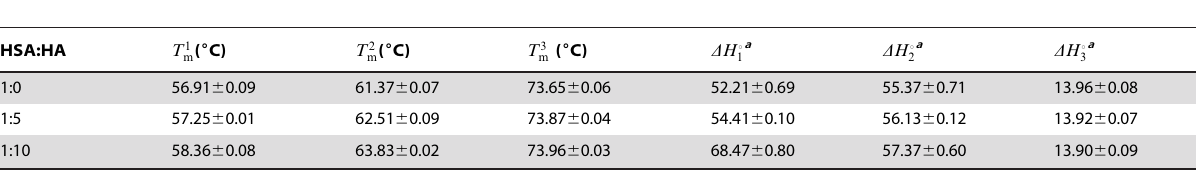
Table 3. Thermodynamic parameters obtained by differential scanning calorimetry.